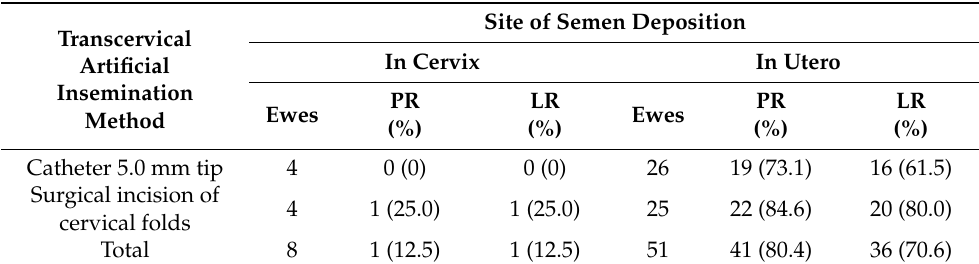
Table 6. Pregnancy (PR) and lambing (LR) rates in relation to the site of semen deposition using two different methods for transcervical artificial